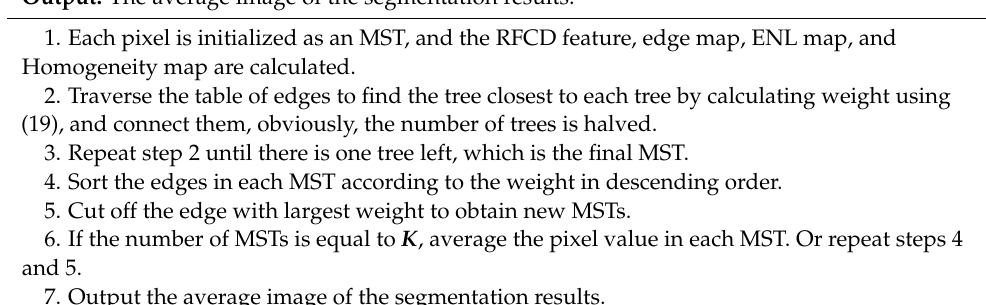
Algorithm 1. Superpixel generation for the PolSAR image.